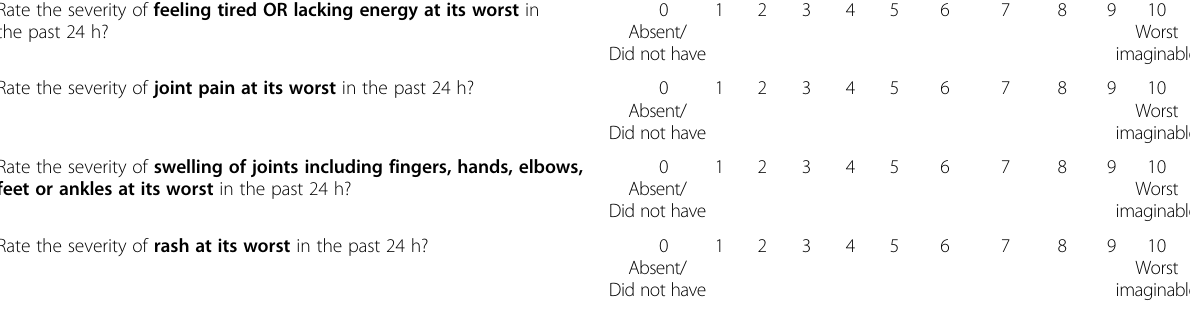
Table 4 Sample questions from the SSD and SIQ Sample questions from the SSD: People with lupus may experience a variety of symptoms. Please indicate how severe the following lupus symptoms were at their worst in the past 24 hours by selecting one